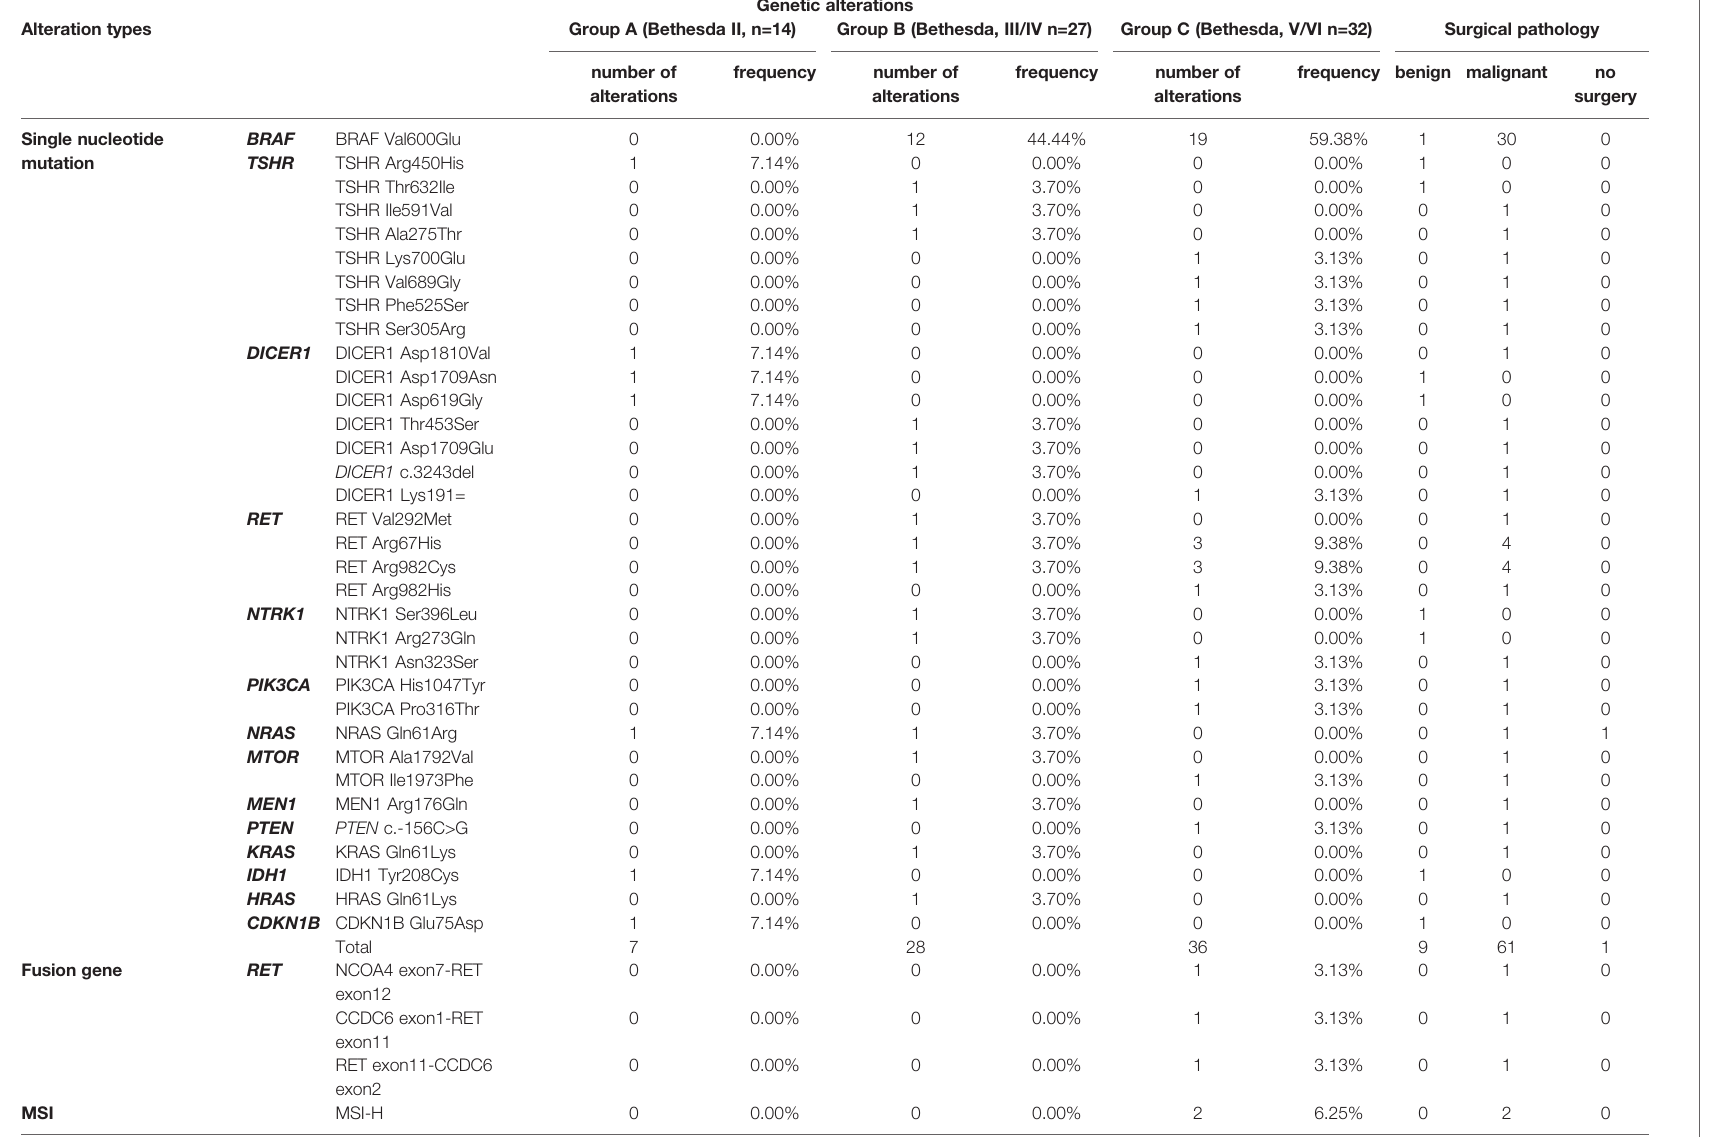
TABLE 2 | Genetic alterations of 73